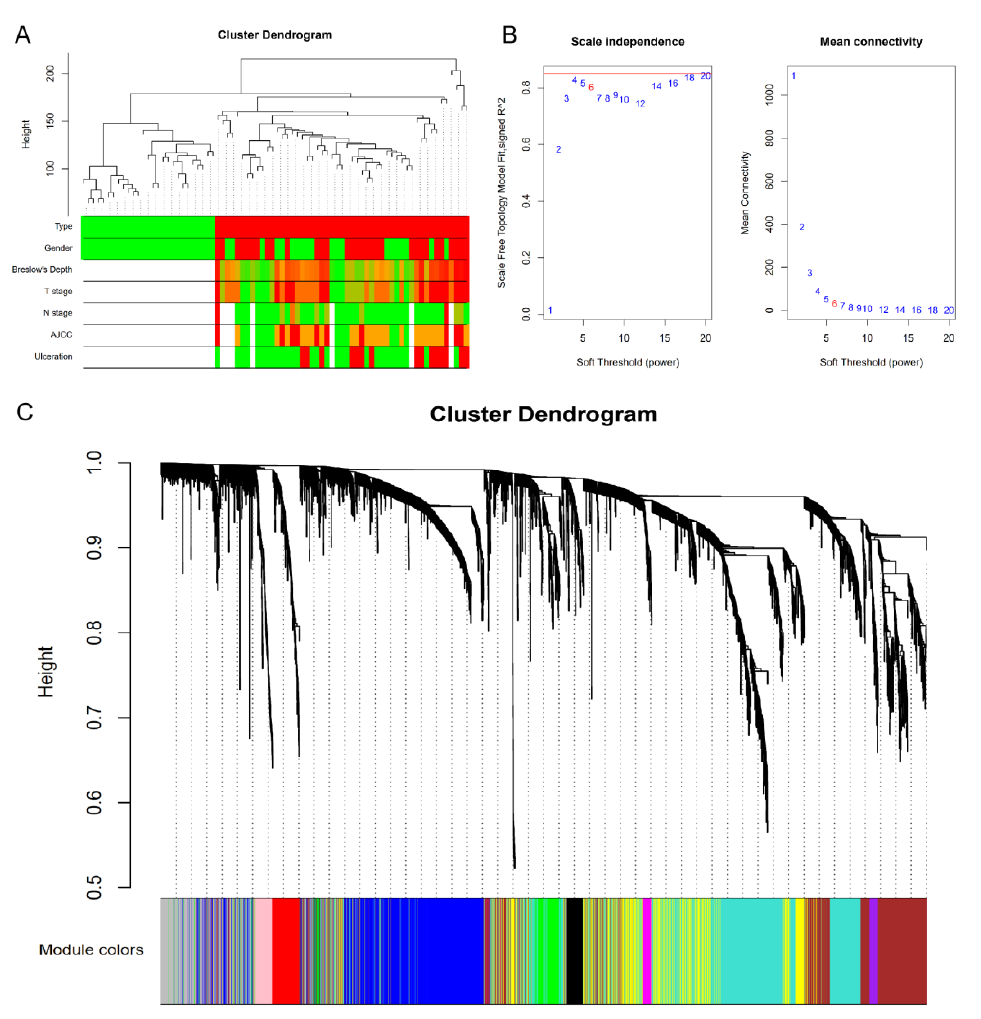
Figure 2. Gene co-expression network and modules. ( A ) Clustering dendrogram of 78 samples. ( B ) Determination of soft-thresholding power in the weighted gene co-expression network analysis (WGCNA). When β = 6, R 2 > 0.8 and mean connectivity < 100, indicating that the network has the characteristics of scale-free topology. ( C ) Dendrogram of all differentially expressed genes clustered based on a dissimilarity measure. The cluster analysis result is shown above, and module identification is shown below.